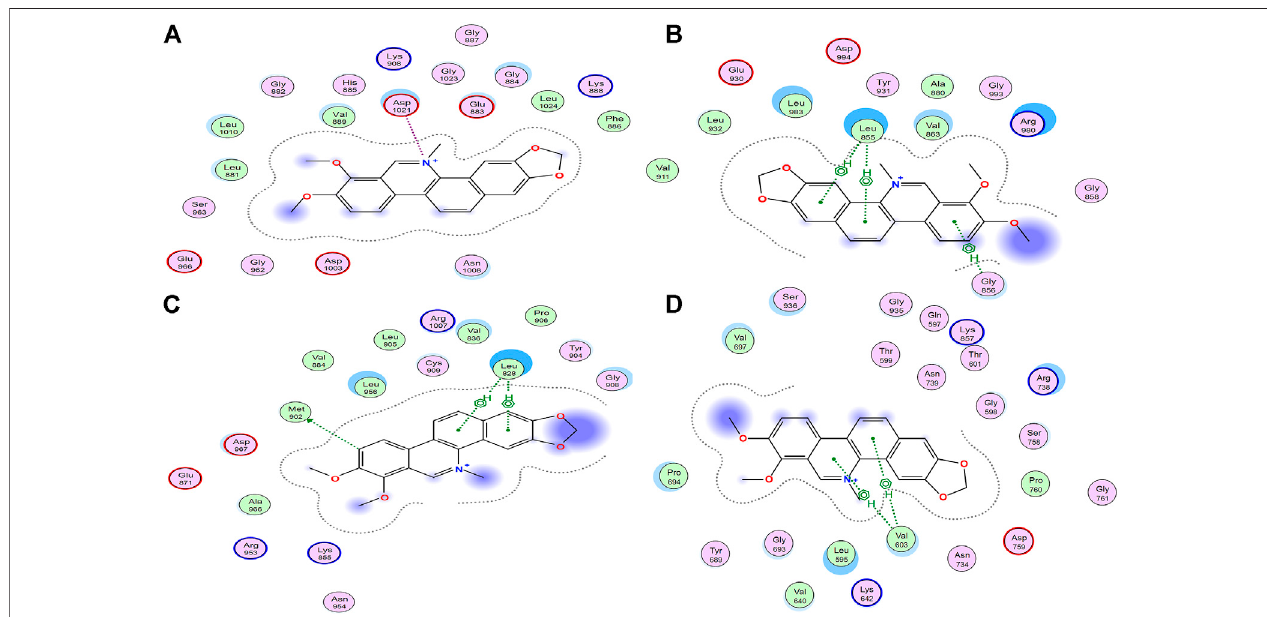
FIGURE4 | Interactions between Chelerythrineand JAKs. Molecular docking was used todisplay the interactionsbetween Chelerythrine and (A) JAK1, (B) JAK2, (C) JAK3, and (D) Tyk2, respectively. Original structures of JAKs receptors were downloaded from RCSB Protein Data Bank (JAK1 PDB: 6SM8; JAK2 PDB: 3KRR; JAK3 PDB: 5TTS; Tyk2 PDB: